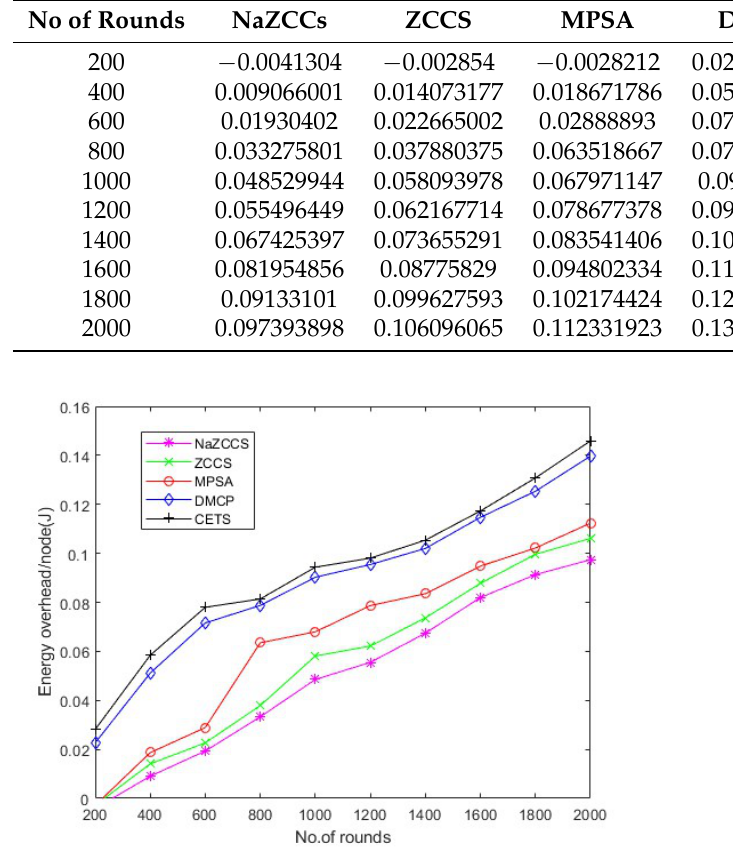
Figure 17. CETS versus other models on energy overhead per round at hop density